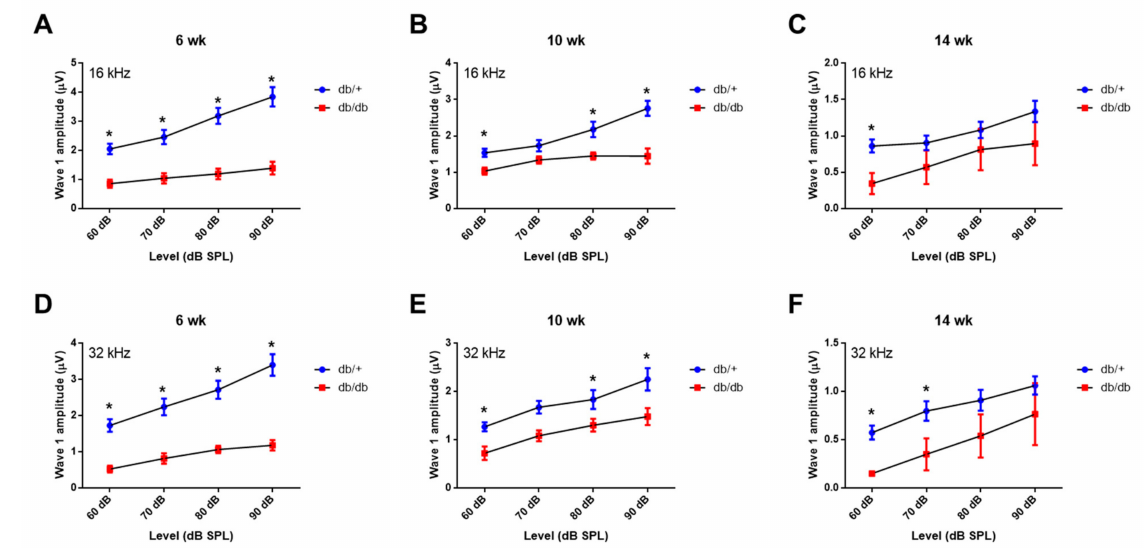
Figure 3. Auditory nerve function was significantly reduced in diabetic mice compared to wild type. ABR wave I amplitudes (a sensitive measure of auditory nerve function) were elicited by tone pips at 16 ( A – C ) or 32 kHz ( D – F ) at 6, 10, and 14 weeks of age. n = 10. Asterisk indicates p < 0.05, unpaired t -test.